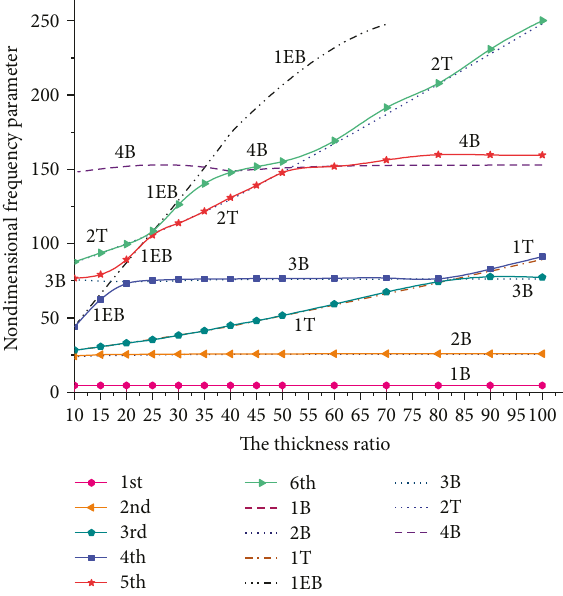
Figure 7: Variations of nondimensional frequency parameters with the thickness ratio ( l = 3 , n = 2 , h